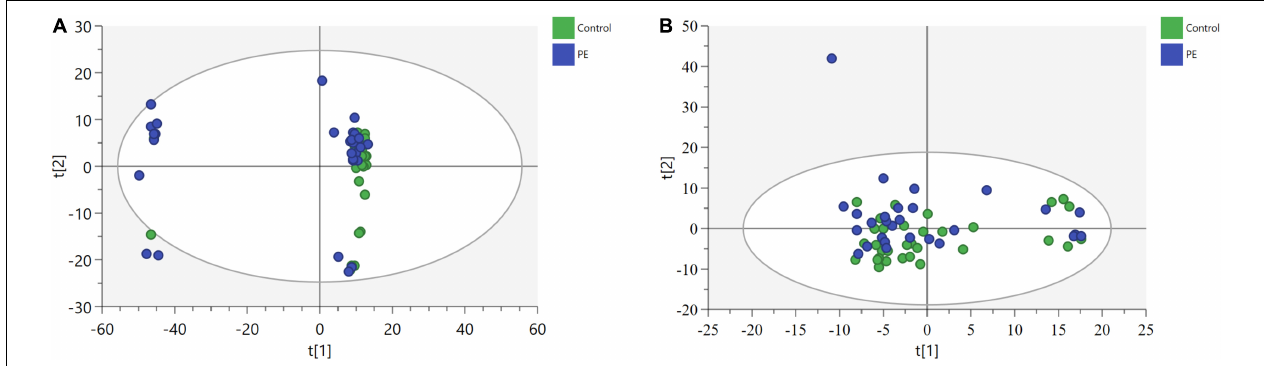
FIGURE 1 | Principle component analysis (PCA) plots show some separation of metabolic profiles between PE (in blue) and non-PE (in green) for (a)UHPLC-QE-MS(+) and (b)UHPLC-QE-MS(–). (A) POS [UHPLC-QE-MS(+)], 3 components model:R2X = 0.655, Q2 = 0.537. (B) NEG [UHPLC-QE-MS(–)], 9 components model:R2X = 0.503, Q2 = 0.141.